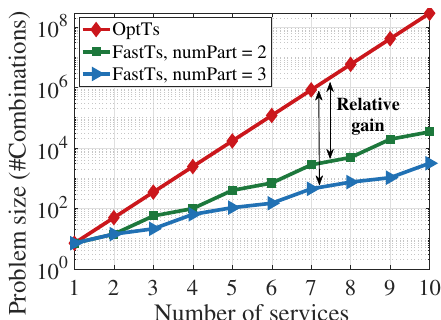
Figure 10. Comparison of problem size between O PT T S and F AST T S . Parameters: N = { 1, · · · ,10 } , T s = 3 for all S k .